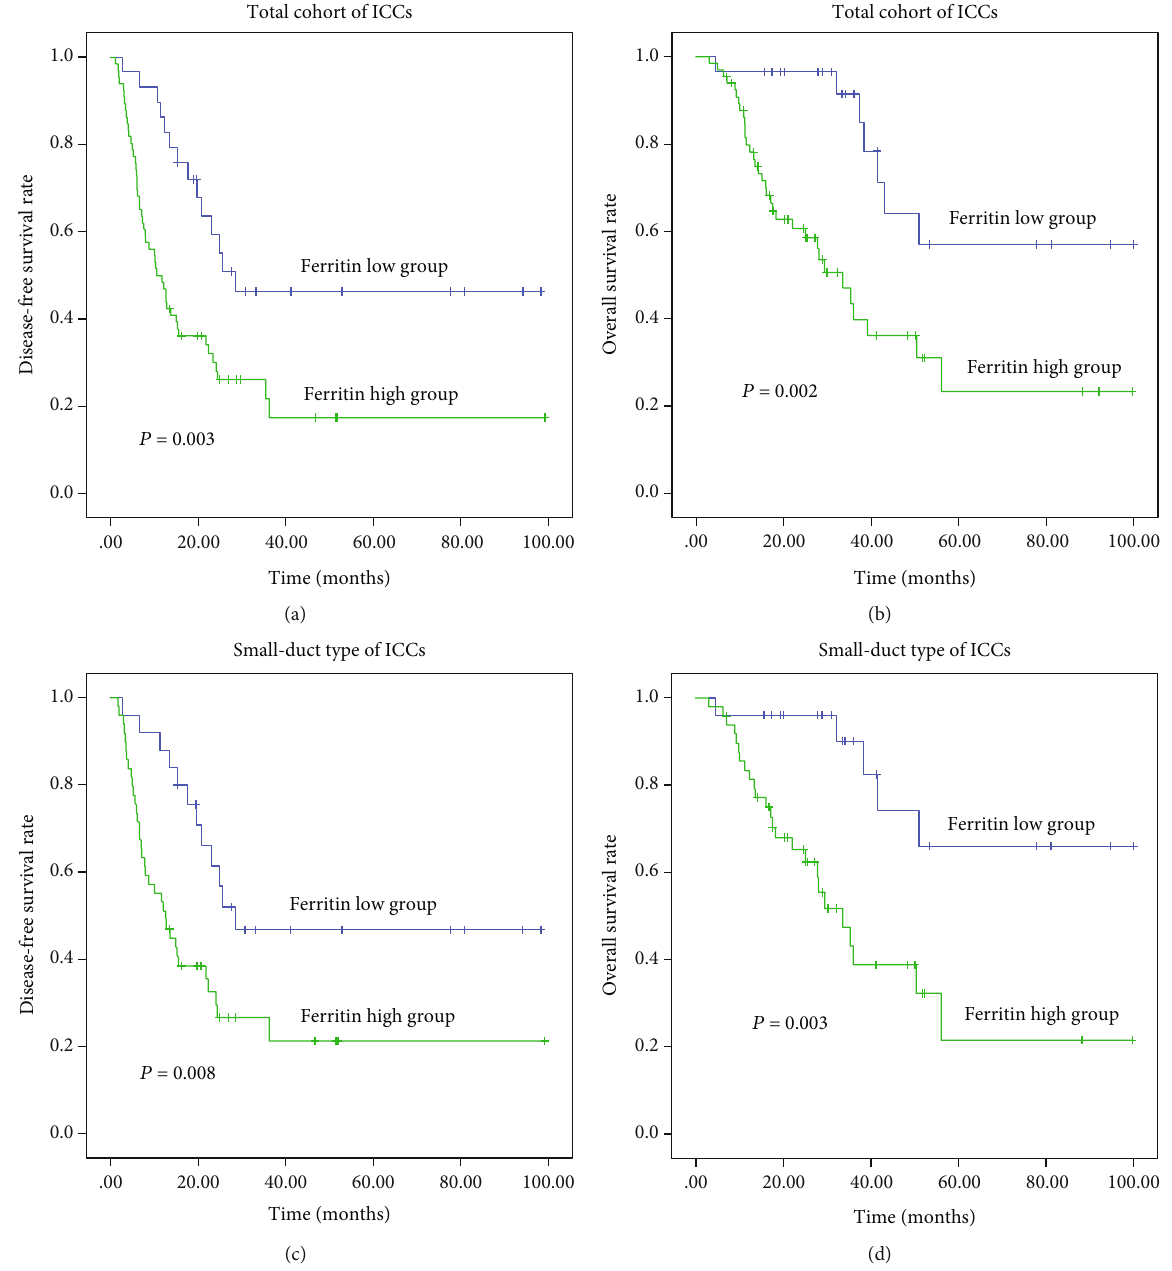
Figure 3: Survival analysis showing patients with high ferritin had poor prognosis in ICCs (a) and (b) and their small-duct type (c) and